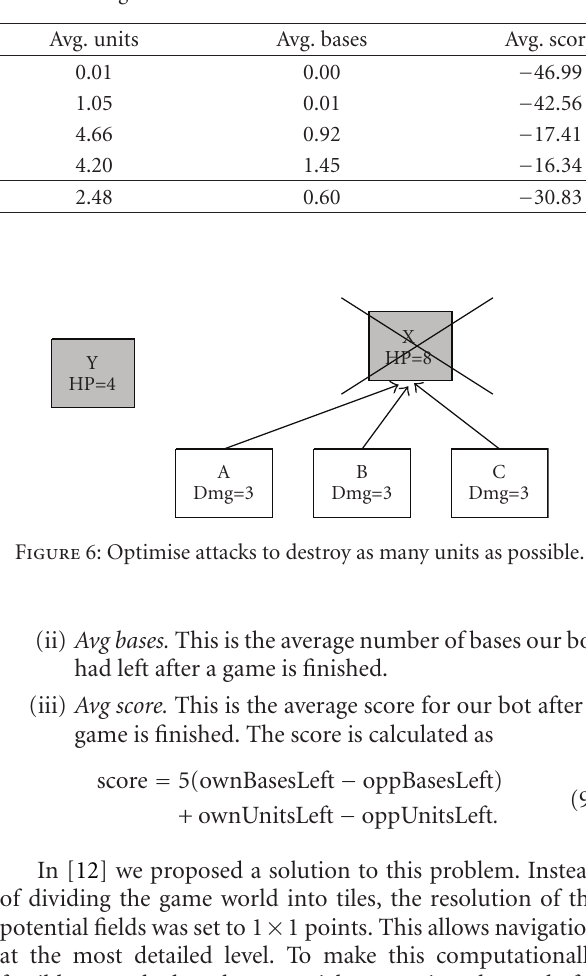
Table 2: Experiment results from the original bot.